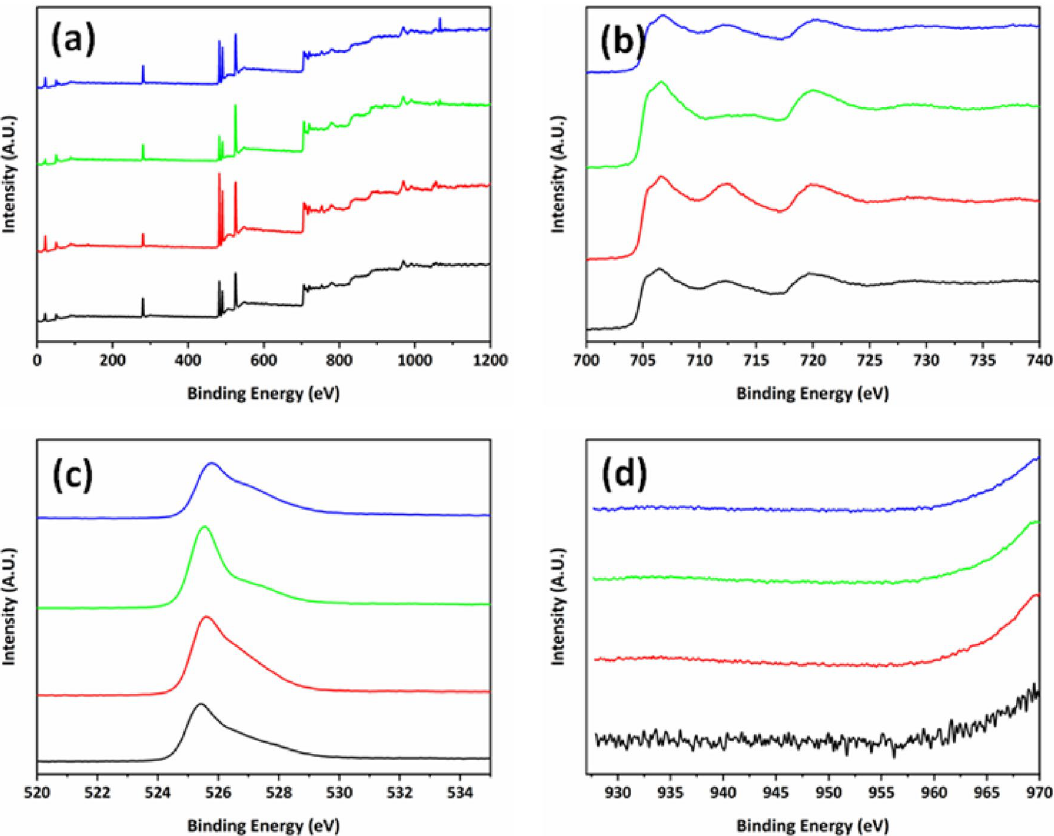
Figure 2. Typical XPS result of hematite thin film and Cu 2+ ion doped hematite thin film with pristine (black), 1 mol% (red), 3 mol% (green), and 5 mol% (blue). ( a ) wide range, ( b ) Fe 2p, ( c ) O 1 s and ( d ) Cu 2p of each hematite thin